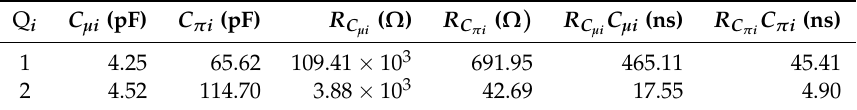
Table 1. RC time constants for the first problem.